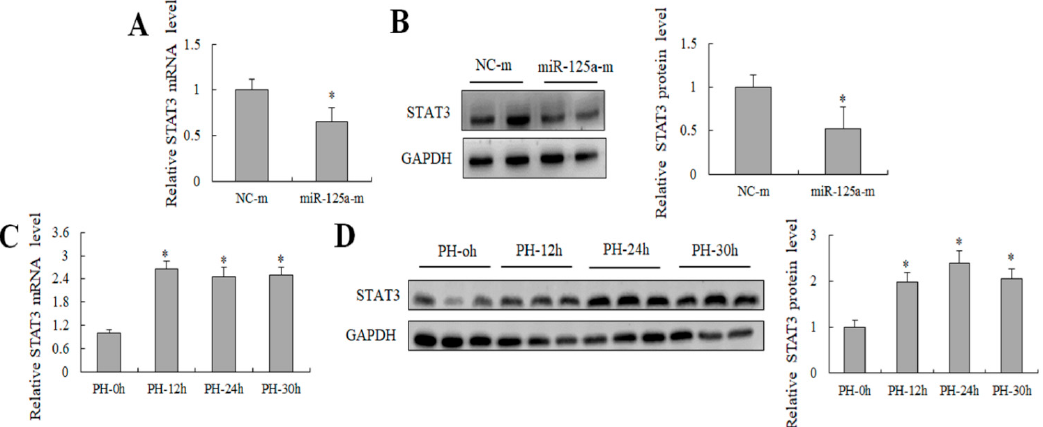
Figure 4. Detection of STAT3 level in vitro and in vivo. ( A ) STAT3 level was examined through qRT ‐ PCR in hepatocytes after treatment of miR ‐ 125a reagents. ( B ) STAT3 level were examined through WB in BRL ‐ 3A after treatment of miR ‐ 125a reagents. ( C ) STAT3 level were examined trough qRT ‐ PCR at 12/24/30 h post ‐ PH (PH ‐ 12/24/30 h) in liver tissues. ( D ) miR ‐ 125a as well as STAT3 level were examined through WB at 12/24/30 h post ‐ PH (PH ‐ 12/24/30 h) in liver tissues. Data are shown as mean ±SEM, * p < 0.05, ** p < 0.01.